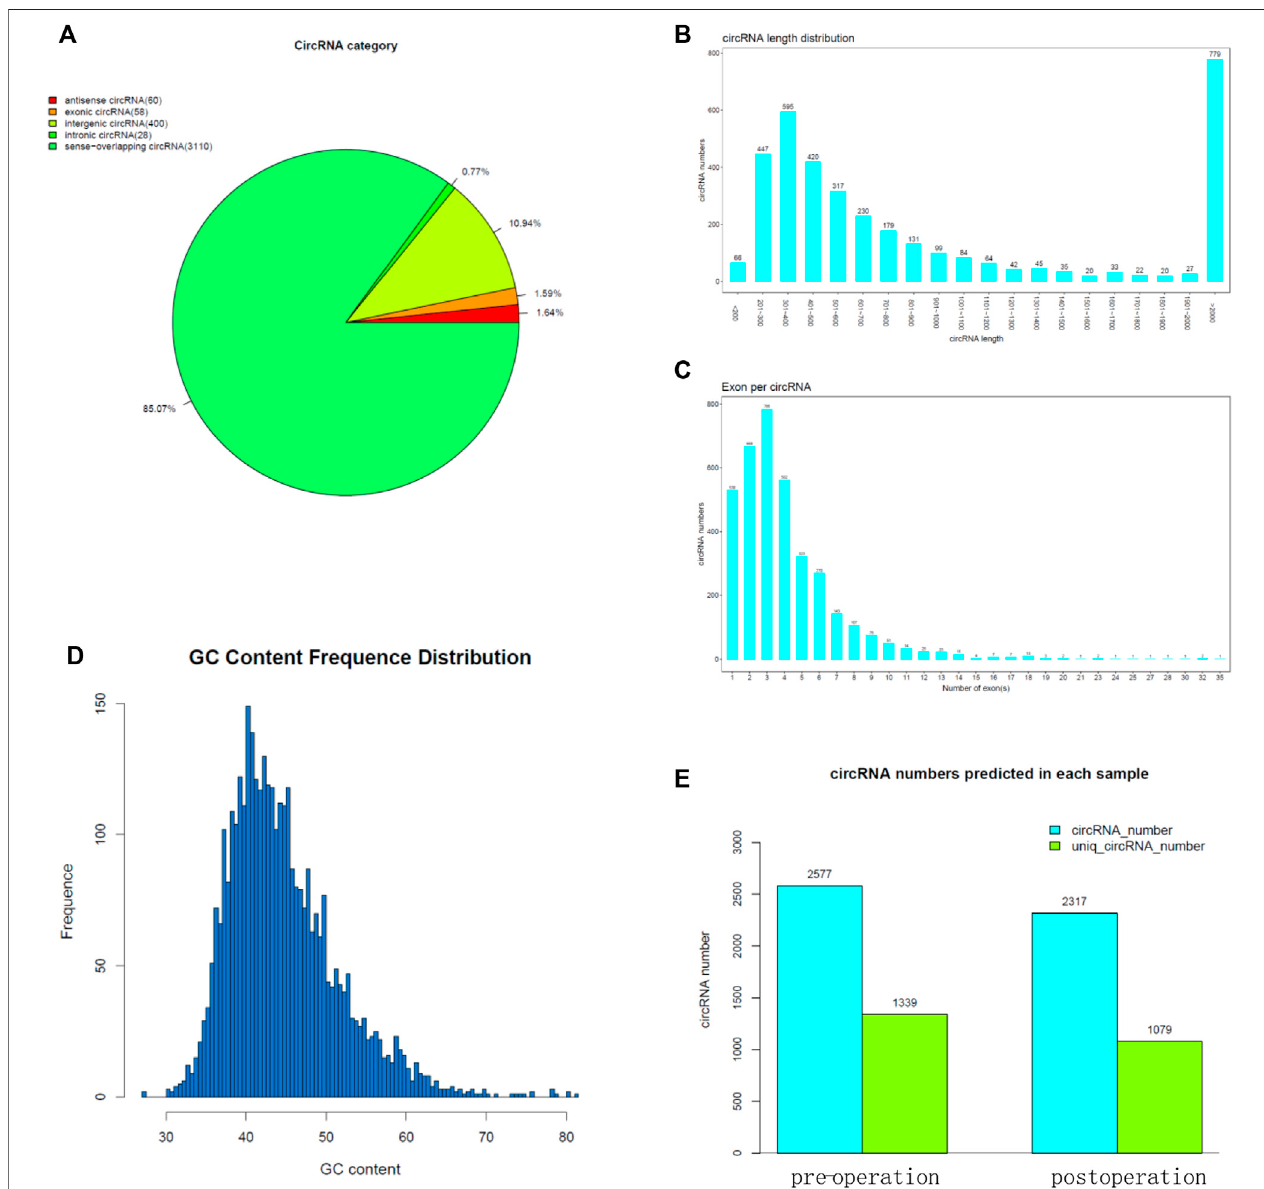
FIGURE 3 | High-throughput sequencing for FLR. (A) CircRNA category of the high-throughput sequencing result. (B) CircRNA length of the high-throughput sequencing result. (C) Exon number per circRNA. (D) GC content frequency distribution of circRNA. (E) CircRNA numbers predicted in each sample.